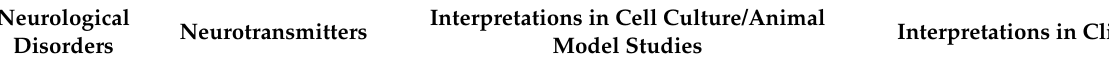
Table 2. Summary of the associations between neurotransmitters and neurological disorders. A list of studies from cell culture, animal models and human cases on the modulation of neurotransmitter production by gut microbiota and its impacts on neurological disorders. Abbreviations: 5-HTP, 5-hydroxytryptophan; AD, Alzheimer’s disease; APOE, apolipoprotein E; GABA, gamma-aminobutyric acid; L -DOPA, L -3,4-dihydroxy-phenylalanine; LC-MS/MS, liquid chromatography tandem mass spectrometry; MCI, mild